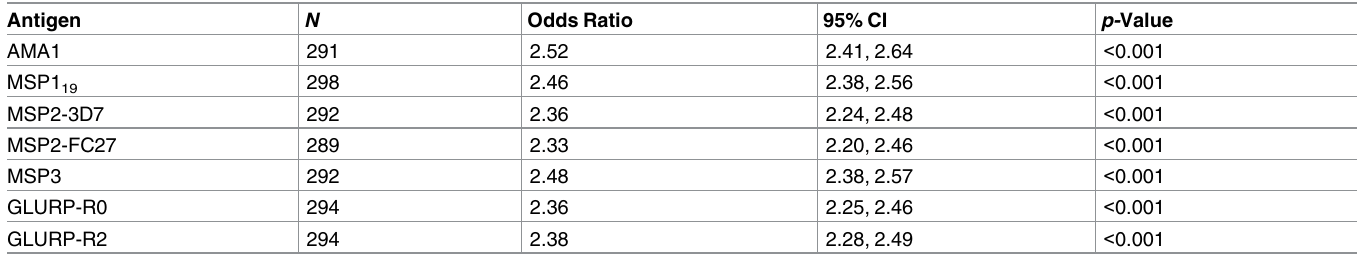
Table 3. Persistence of malaria-specific IgG3 at 6 months of age related to level of maternal anti-malaria IgG3.